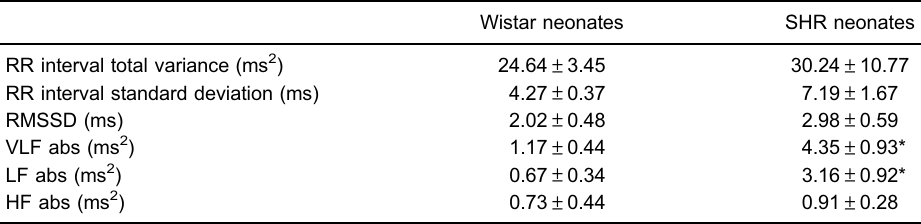
Table 1. Heart rate variability parameters in time and frequency domains of normotensive Wistar neonates and spontaneously hypertensive (SHR) neonates. Wistar